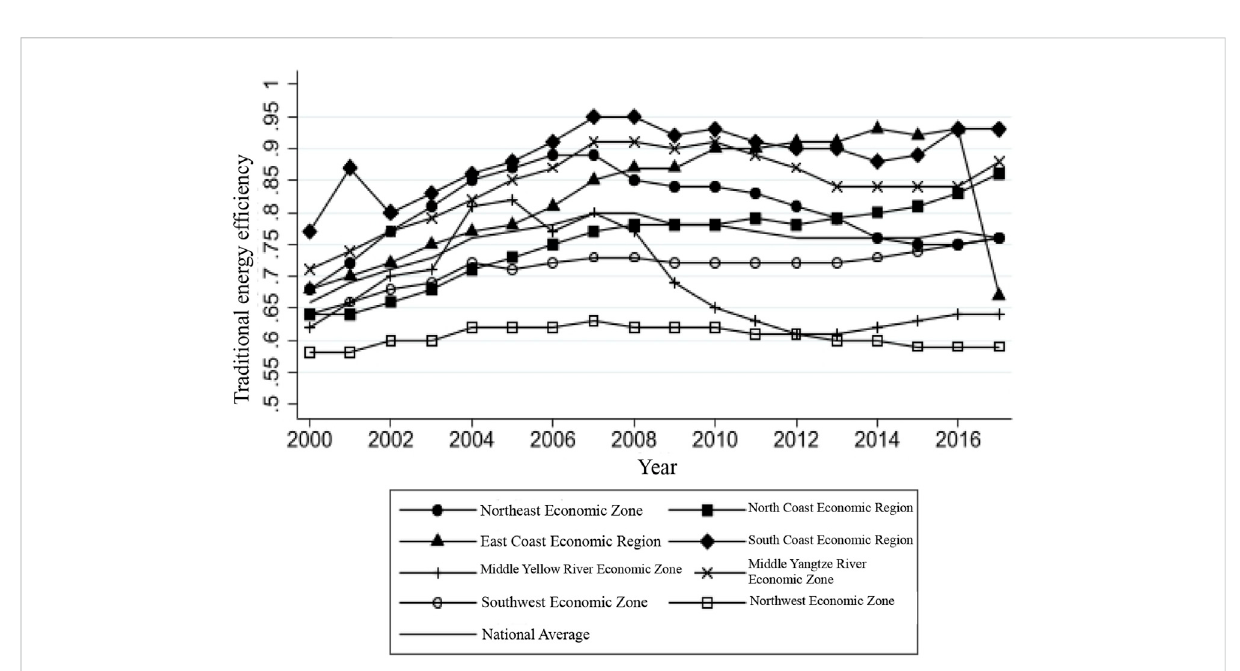
FIGURE 2 2000-2017 fossil energy ef fi ciency structure of China ’ s eight economic